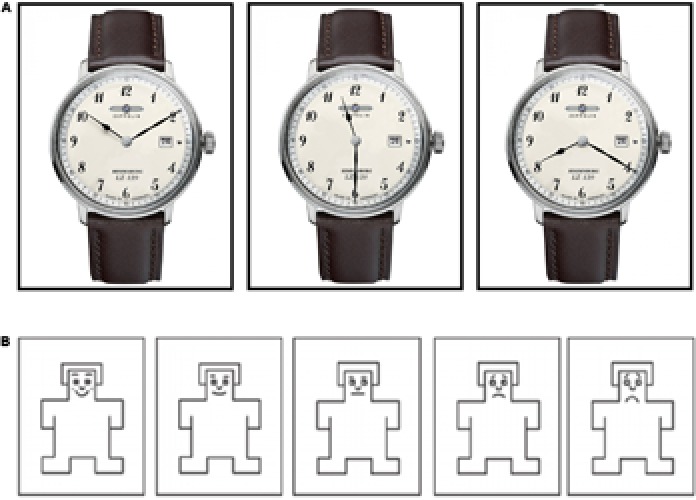
Examples of the stimuli used in the first experiment. (A) Depicts one of the used watches with the three different time settings (10:10, 11:30, and 08:20). (B) Shows the pleasure scale from the Self-Assessment Manikin (SAM) of Bradley and Lang (1994). The most positive face was coded with number 5 while the most negative face was coded with number 1.